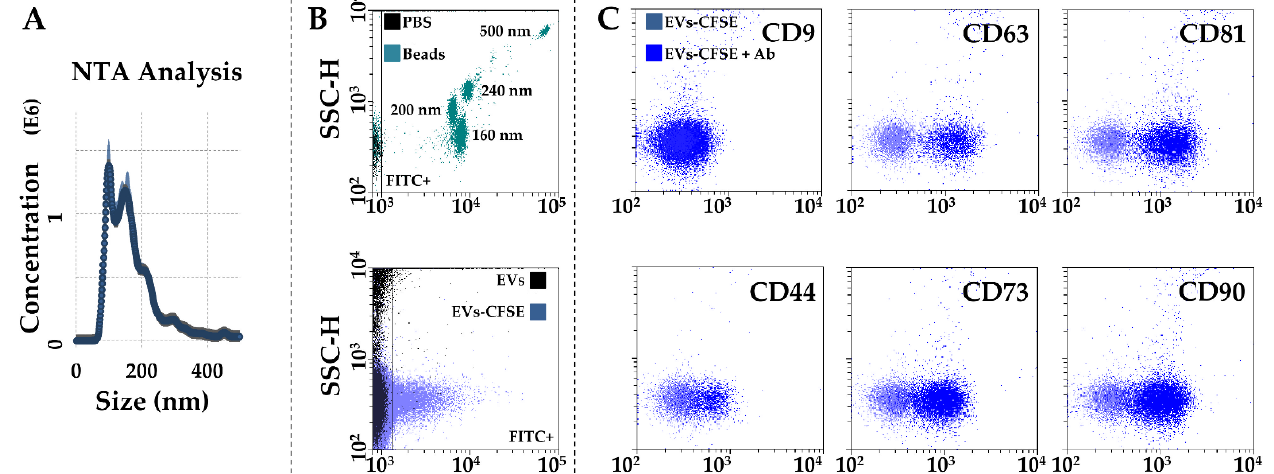
Figure 4. Characterization of PRP-treated BMSC-EVs. ( A ) EVs size analysis from NTA data. ( B ) Flow cytometer calibration to solve FITC-nanobeads, starting from 160 nm (upper panel), and CFSE-labeled EV detection (lower panel) in the FITC channel. ( C ), after gating, CFSE + EVs showed positive staining for CD63 and CD81 EV-defining markers, and CD44, CD73, and CD90 MSC markers. CD9, another EV-postulated marker, was barely detectable. Representative cytograms are presented.